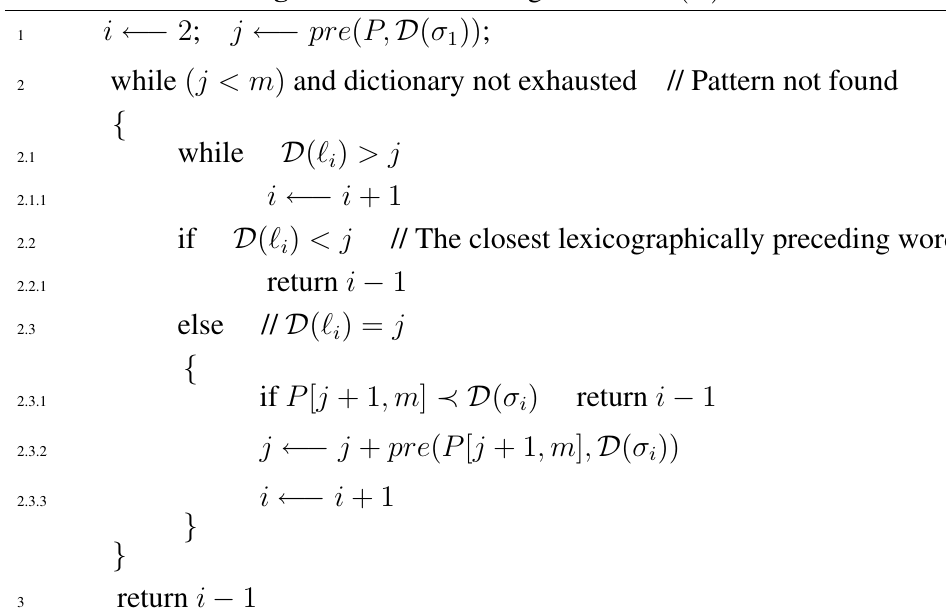
Algorithm 1. Searching for P in D ( T )